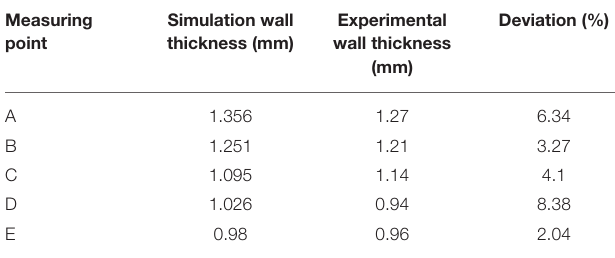
TABLE 5 | The wall thickness error table. Measuring point